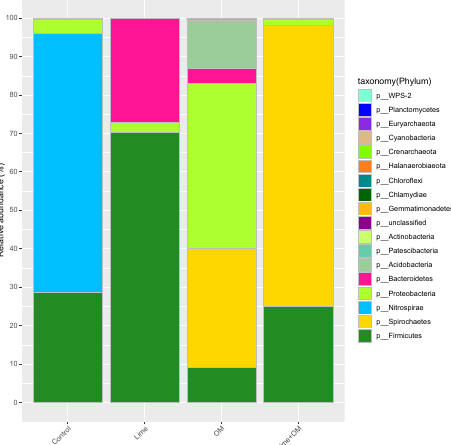
Figure 2. Phylum of the microbial community in the solution phase of the four columns (control, Lime, organic matter (OM), and Lime + OM) at day 150.